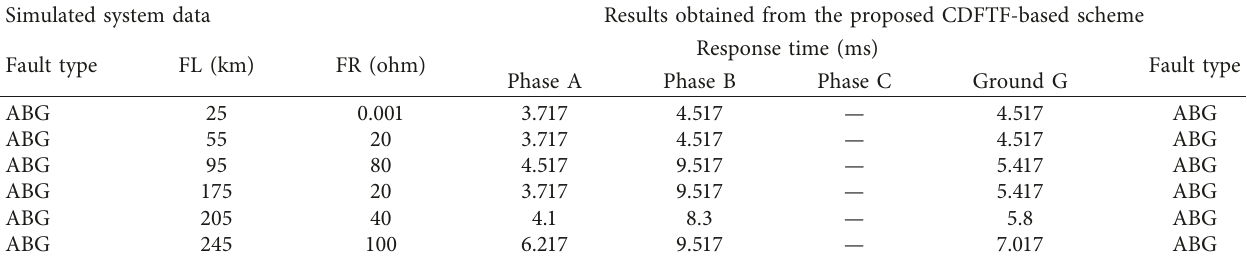
Figure 4: Performance during AB fault at 135 km, FIA � 0 ° , and FR � 10 Ω : (a) 3-phase voltage waveform; (b) 3-phase current waveform; (c) output of Table 5: Effect of fault resistance (FIA � 45 ° ). Simulated system data